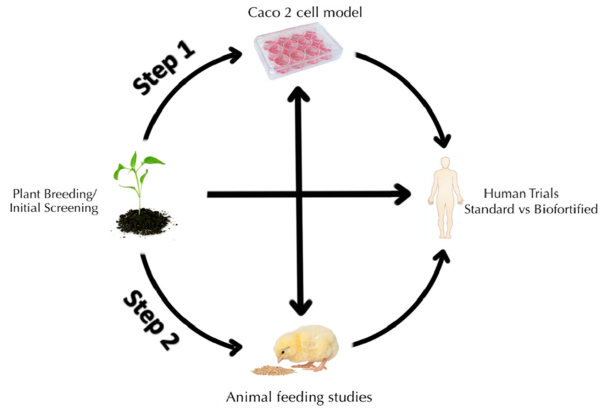
Figure 5. Schematic diagram depicting Fe bioavailability screening of biofortified staple food crops.